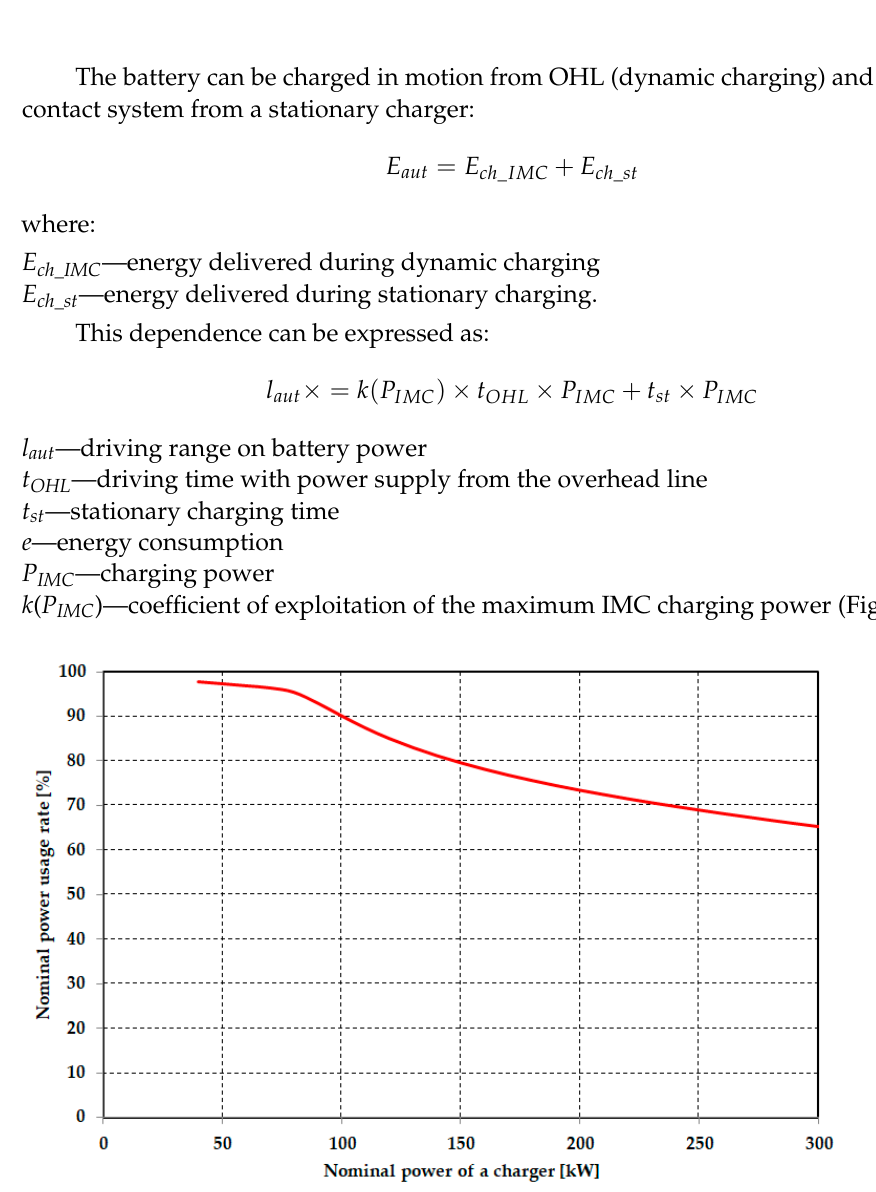
Figure 4. Nominal usage of the charger power (source: own elaboration).